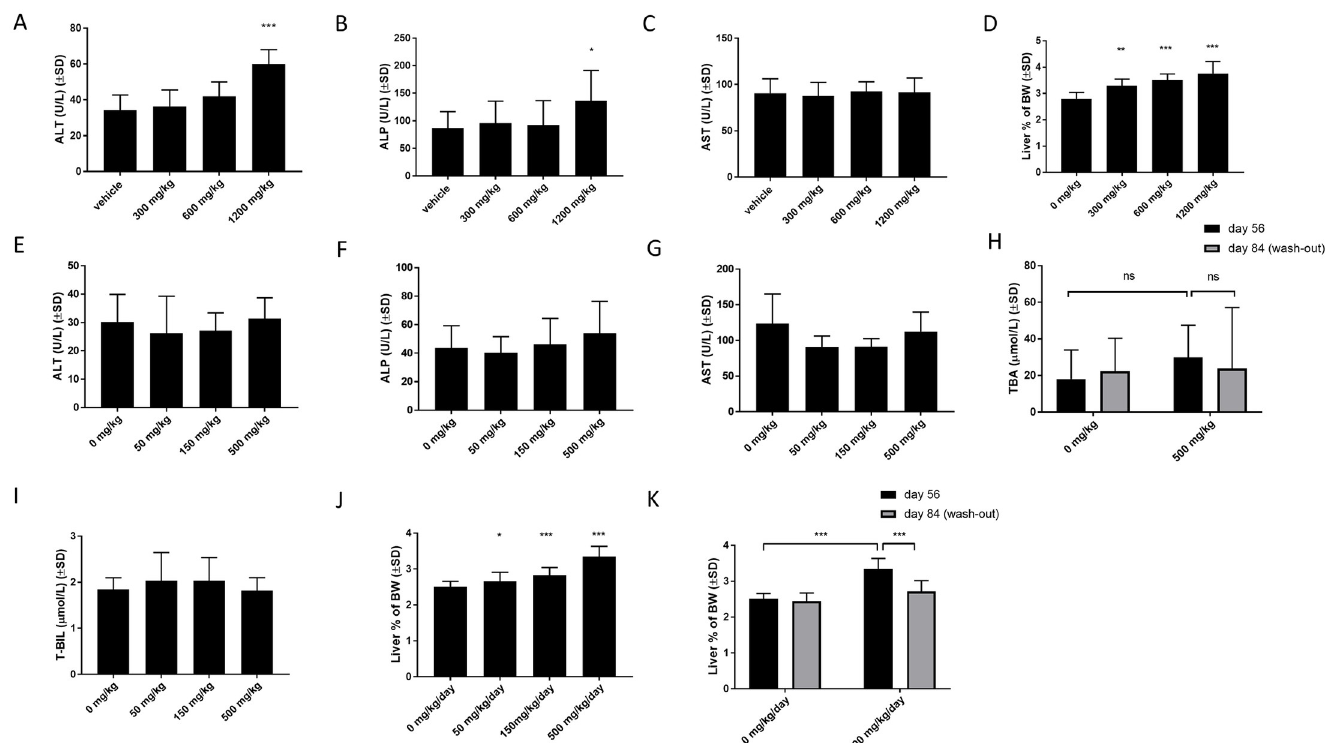
Fig 8. The effect of CPL207280 on liver toxicity markers in rats treated chronically. Serum levels of the biochemical markers (A-C) and liver mass (D) after 14 days of treatment. Data are mean ± SD, n = 10 (5 males + 5 females). Serum levels of the biochemical markers (E-I) and liver mass (J, K) in rats treated for 56 days. Statistical analysis was performed using One-way ANOVA, followed by Dunnett’s post-hoc test. Levels of TBA and changes in liver mass after wash-out were analyzed using Two-Way ANOVA followed by Sidak’s post-hoc test; ��� , p < 0.001; �� , p < 0.01; � , p < 0.05; n = 20 (10 males + 10 females). T-BIL—total bilirubin; TBA—total bile